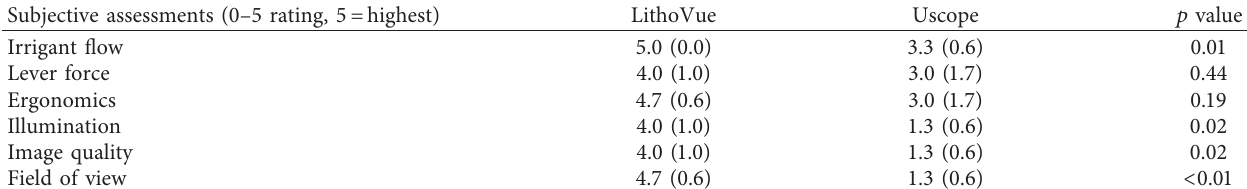
Table 3: Subjective surgeon assessments of irrigant flow, lever force, ergonomics, and scope optics between LithoVue and Uscope after completion of 35 passes of the ureteroscope.